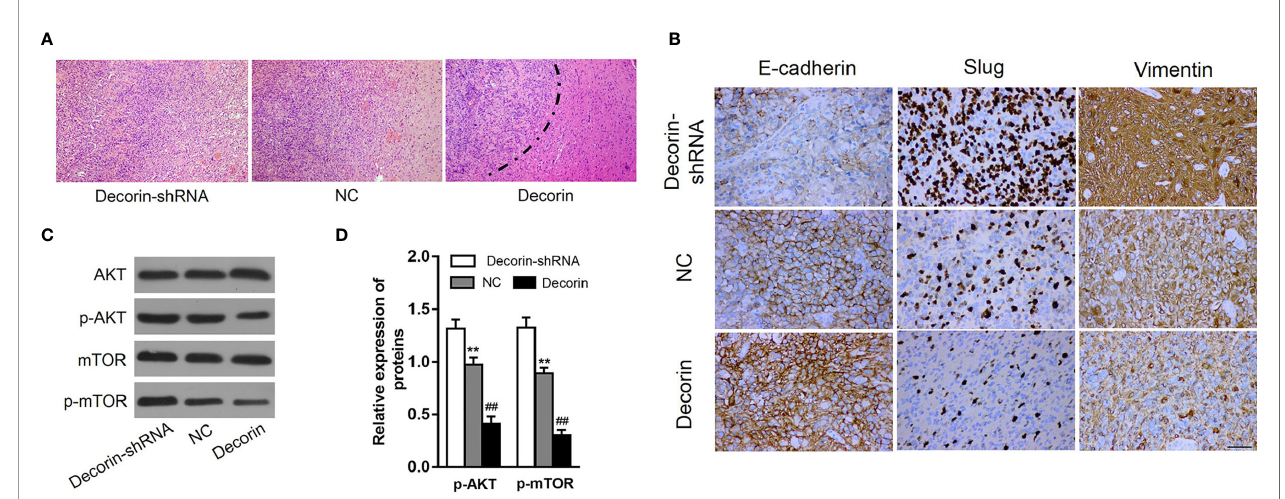
FIGURE 6 | Decorin overexpression suppresses GBM invasion and EMT phenotype. (A) The result of HE staining showed that U251-shNC tumor or U251-decorin- shRNA tumor tended to invade the neighboring normal tissue, however, the U251-decorin tumor kept a relative smooth edge. (B) The expression of mesenchymal markers including Slug and vimentin were up-regulated greatly in U251-decorin-shRNA tumors. The expressions of these proteins were decreased in U251-shNC tumors, and further signi fi cantly decreased in U251-decorin tumors. Conversely, the epithelial marker E-cadherin was down-regulated in U251-decorin-shRNA tumors, and the expression was increased in U251-shNC tumors, and further signi fi cantly increased in U251-decorin tumors. (C) The phosphorylated levels of Akt and mTOR were notably up-regulated in U251-decorin-shRNA tumors compared to those in U251-shNC tumors, and these phosphorylated levels were further decreased in U251-decorin tumors. (D) Measurement data of (C) (means ± S.D. @ of 3 independent experiments). **P < 0.01 vs. Decorin-shRNA; ## P < 0.01 vs.